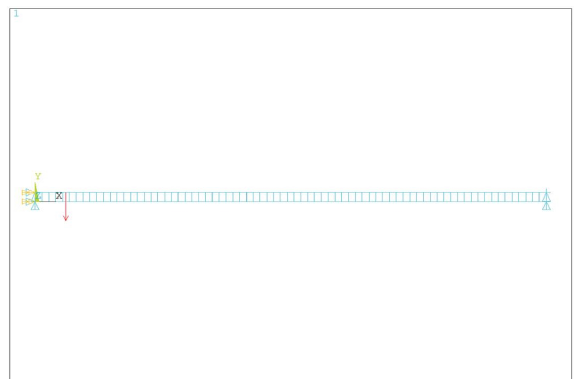
Figure 13: Finite element model of the double-beam metamaterial with 75 unit